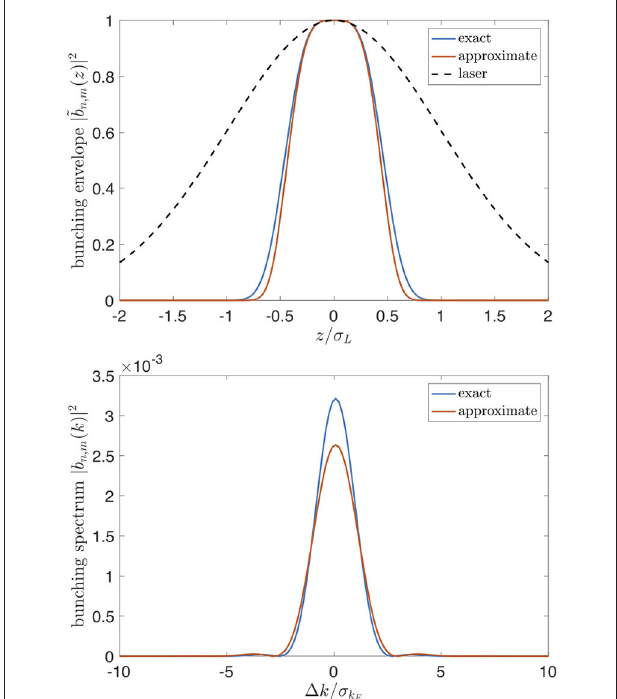
FIGURE 1 | (Top) Bunching envelope and harmonic compression effect for m =50. The approximate super-Gaussian g ( z ) is slightly narrower than the exact solution. (Bottom) Corresponding frequency